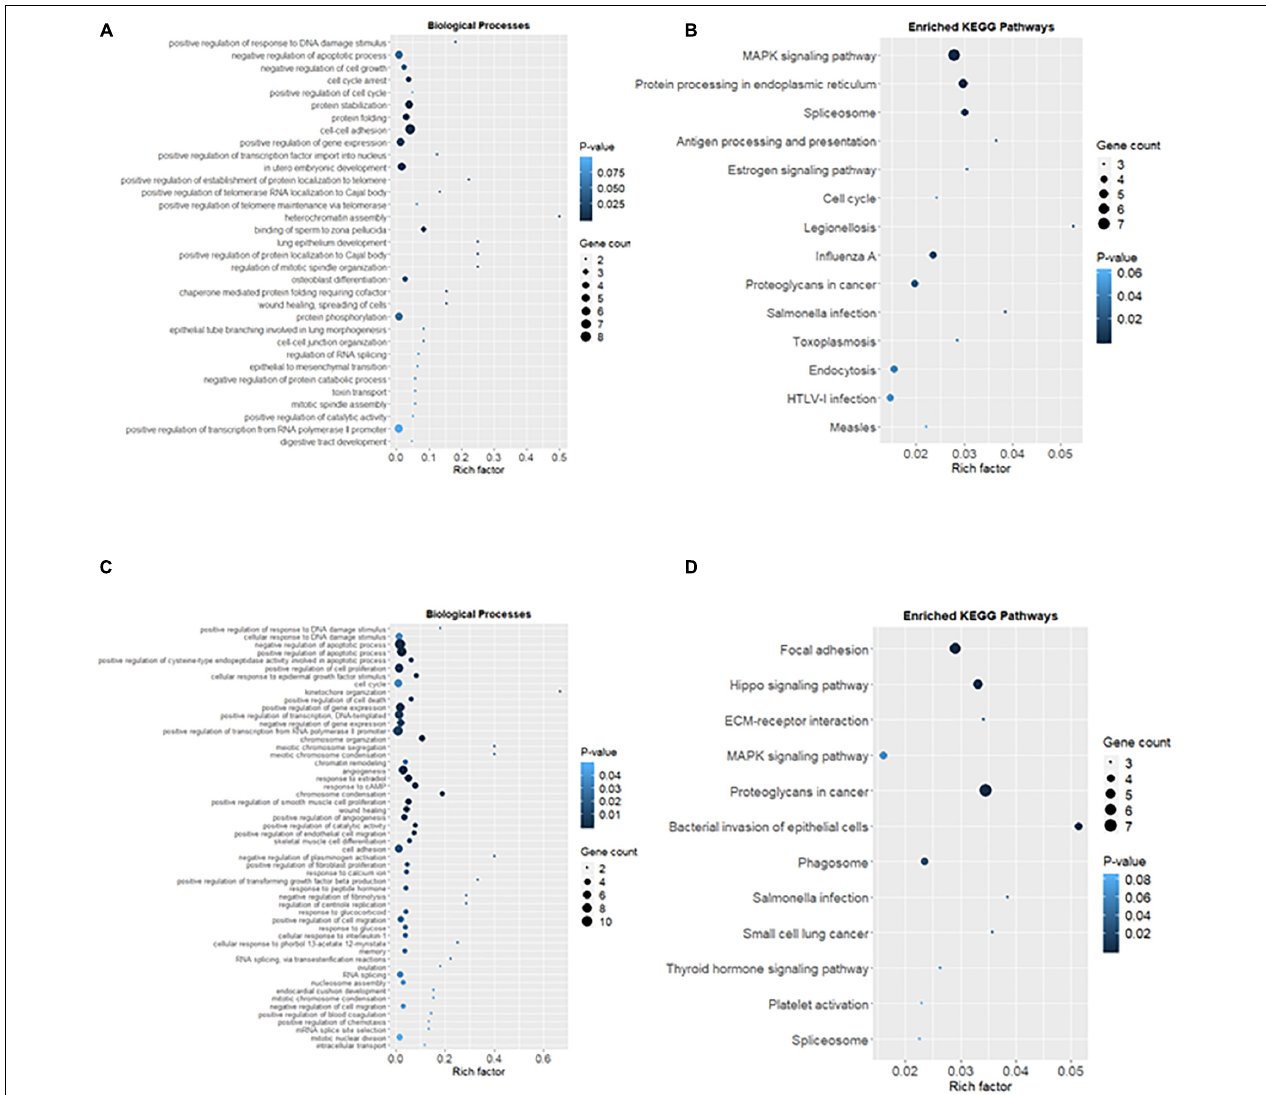
FIGURE 4 | Alteration of biological processes and signaling pathways in the reproductive cells caused by the ionizing radiation. (A) Rich factor plot showed the altered biological processes related to DNA damage responses and cell apoptosis and telomere structure in female reproductive cells using Gene Ontology (GO) enrichment analysis. (B) Rich factor plot showed the altered cell signaling pathways in the female reproductive cells after the ionizing radiation exposure using Kyoto Encyclopedia of Genes and Genomes (KEGG) analysis. (C) Rich factor plot showed the altered biological processes related to DNA damage and chromosome organization in male reproductive cells using GO enrichment analysis. (D) Rich factor plot showed the altered cell signaling pathways in the male reproductive cells after the ionizing radiation exposure using KEGG analysis. The size of dot represented the number of gene. The color intensity of dot represented the significance of the biological processes and cell signaling